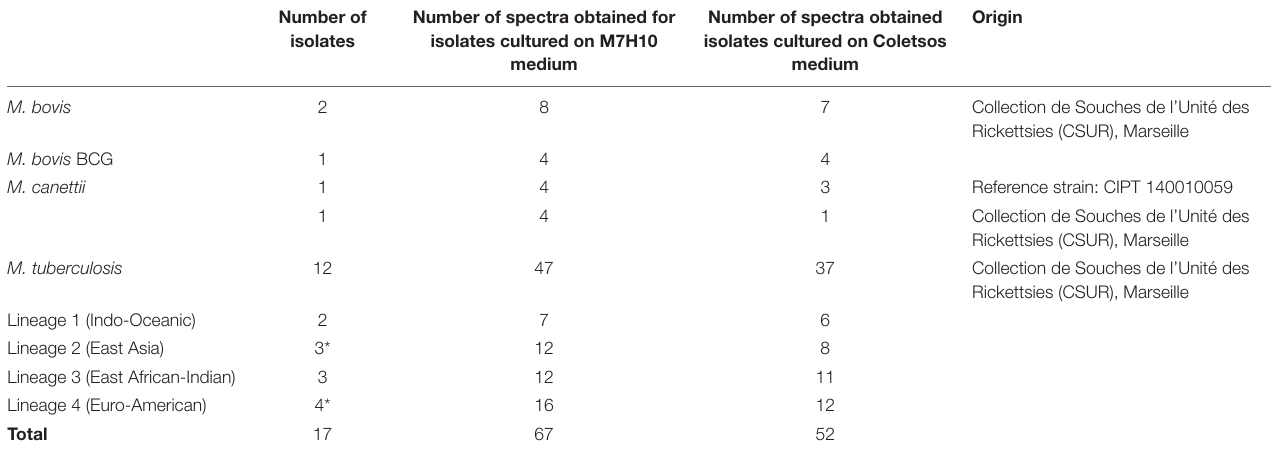
TABLE 2 | Mycobacterial isolates and associated spectra from cultures grown on different